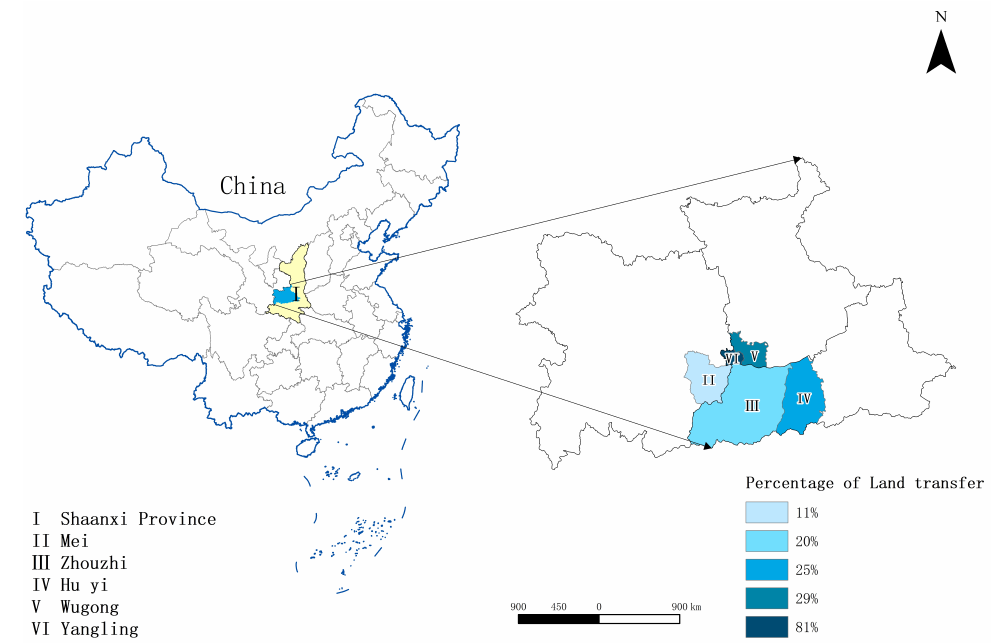
Figure 2. Location of the study sites in Shaanxi, China, with the kiwi planting area highlighted in